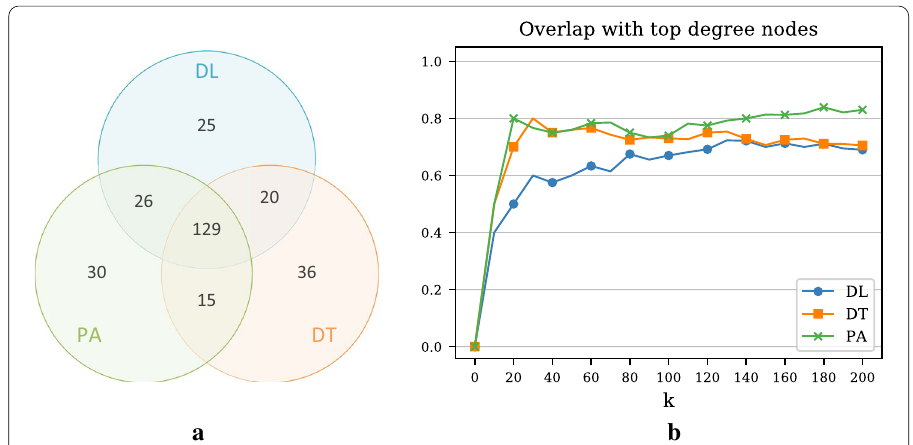
Fig. 3 Comparison of three objectives and degree heuristic (Example 1). a Venn diagram representing the overlap of the top 200 nodes for the three different objectives. b Overlap of the three objectives with the degree heuristic (measured as the size of the intersection divided by k ) for increasing